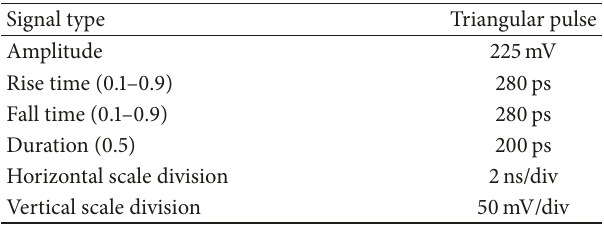
Table 7: Signal parameters at the pulse shaper output.